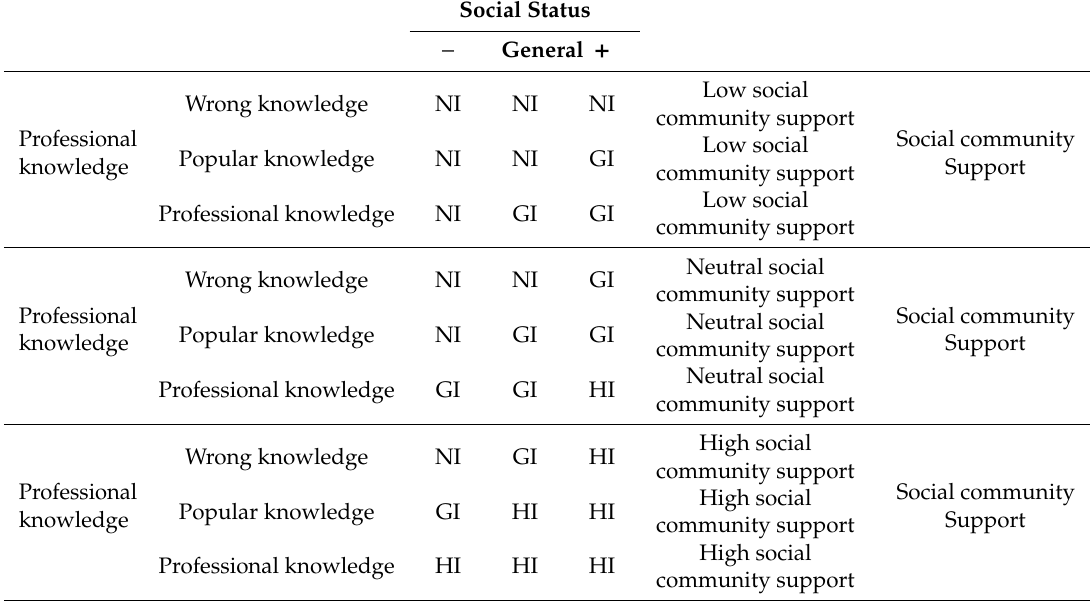
Table 1. Influence power table (NI: No Influence, GI: General Influence, HI: High